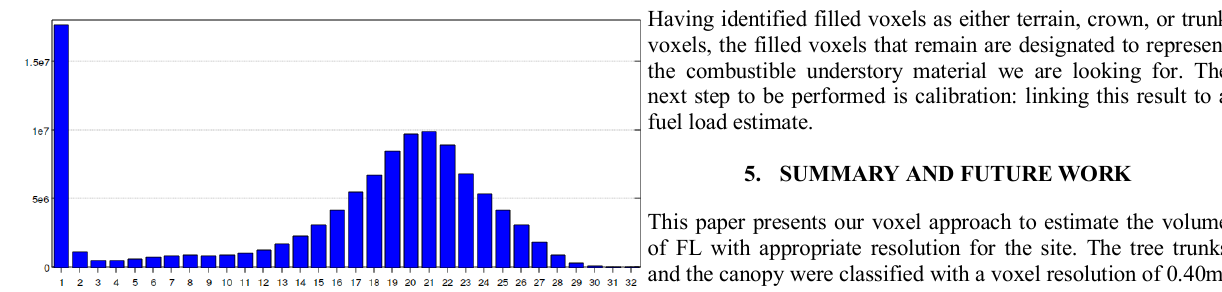
Figure 13: Vertical distribution of LiDAR points in 1m bins